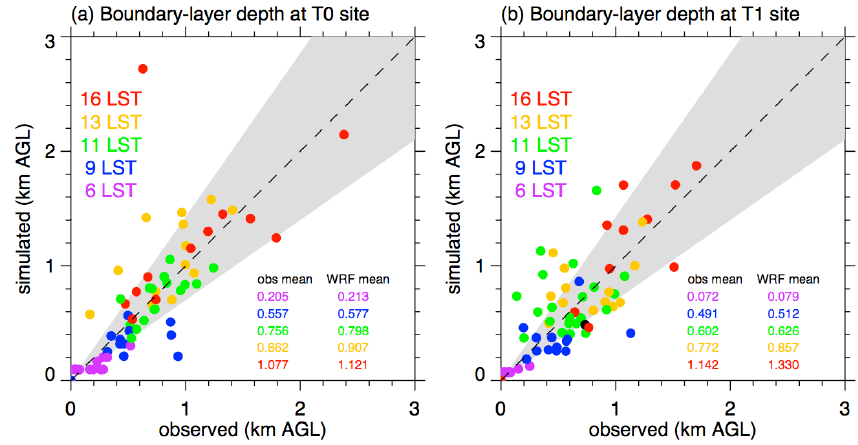
Fig. 9. Observed and simulated convective boundary layer (CBL) depths at various times of day at the (a) T0 and (b) T1 sites. Observed values were obtained from radiosondes launched up to 5 times per day. Dashed line denotes 1:1 line while gray shading denotes ± 30% range.